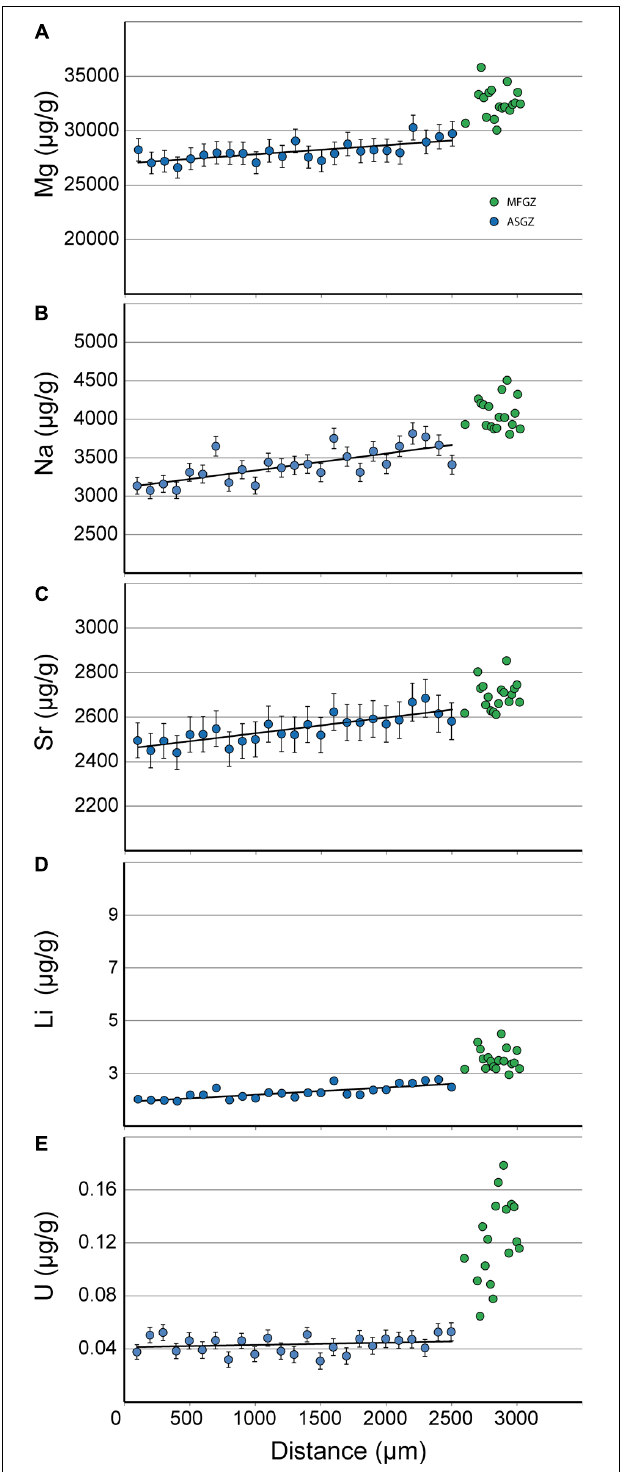
FIGURE 8 | LA-ICPMS analytical traverse in C. konojoi . (A–E) Mg, Na, Sr, Li, and U traverses in a section of C. konojoi . Some analytical points in the medullar zone are not aligned along the traverse (see Figure 1d for a case of misalignment in the medullar zone). Error bars for lithium are smaller than the dot. Error bars in the medullar zone are not reported for clarity.